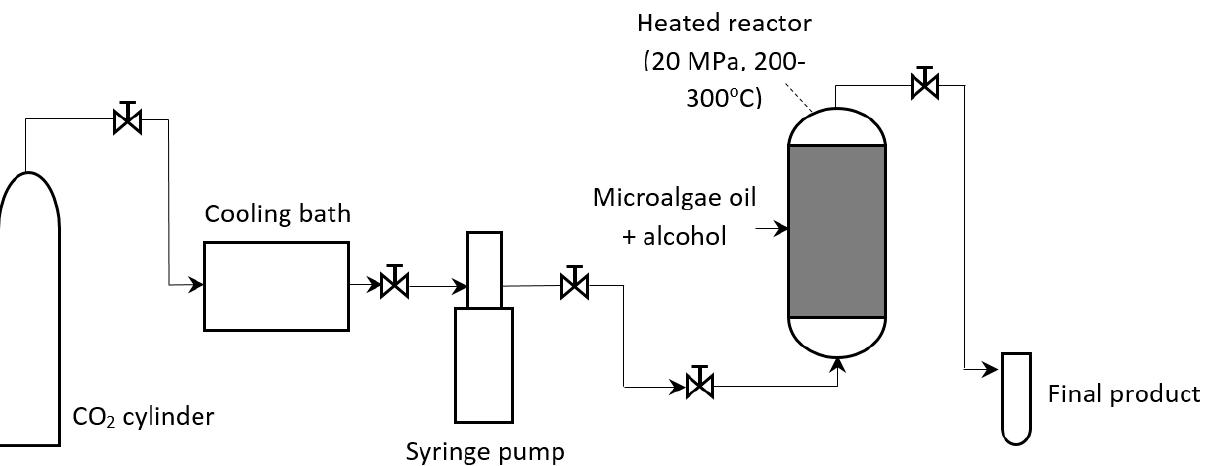
Figure 9. Schematic diagram of a supercritical reaction unit in the production of biodiesel from microalgae [212].